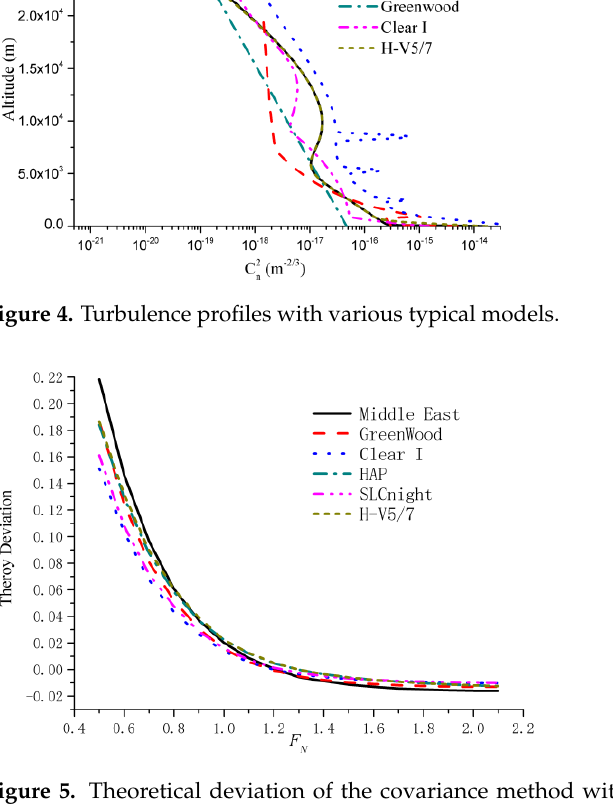
Figure 4. Turbulence profiles with various typical models.